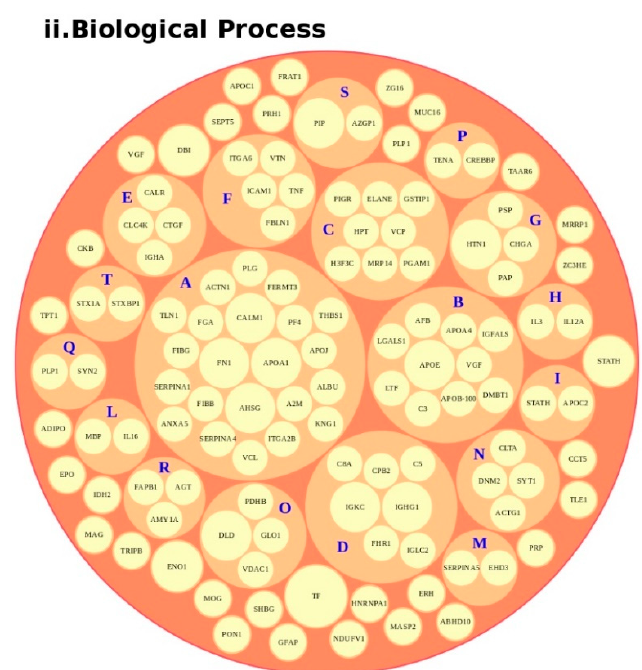
Figure 4. Protein analysis as a tool for the decision support system (DSS). In box ( i ), we grouped the proteins highlighted in Table 1 and Table S1 according to the matrix in which the proteins were studied, such as blood ( orange ), blood and urine ( lawn green ), brain ( red ), dried blood ( brown ), urine ( pink ), and brain biopsies, urine and blood ( lilac ). The size of the bubbles indicates the number of times the protein was found in that matrix in the di ff erent studies taken into consideration. In box ( ii ), we analyzed the data for the biological process and clustered the protein. Legend code: (A) platelet degranulation (GO:0002576); (B) cellular protein metabolic process (GO:0044267); (C) neutrophil